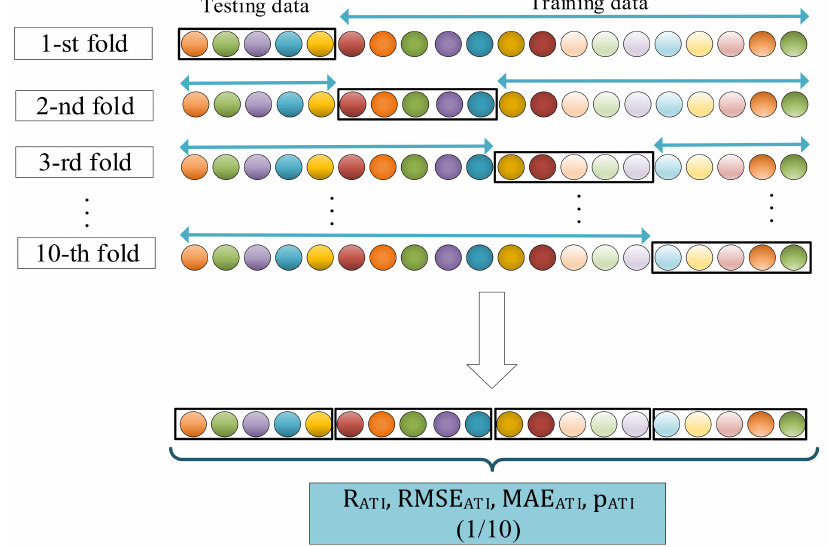
Figure 6. The illustration of the 10-fold cross-calibration process (adapted from Wikimedia Commons, the free media